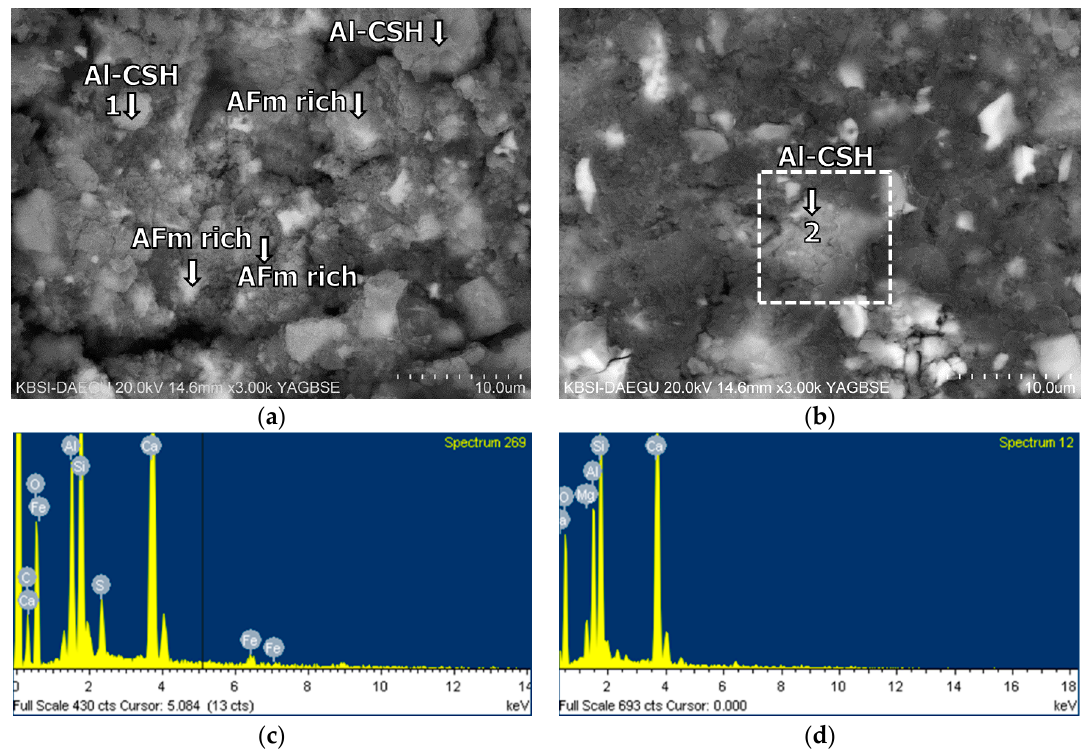
Figure 14. The microstructures of mixture B-0-Y at 60 days: BSE images magnified by ( a ) ×3000; and ( b ) ×3000; EDS spectra of ( c ) point 1 in ( a ); and ( d ) point 2 in ( b ). Mixture B-10-Y at 28 days of curing also contained both the unhydrated and hydrated phases